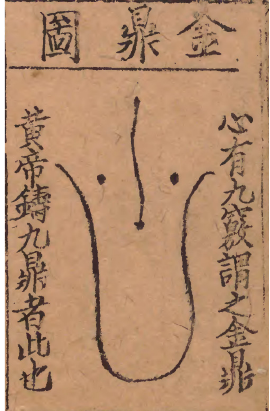
Figure 7. Picture of the Golden Tripod.